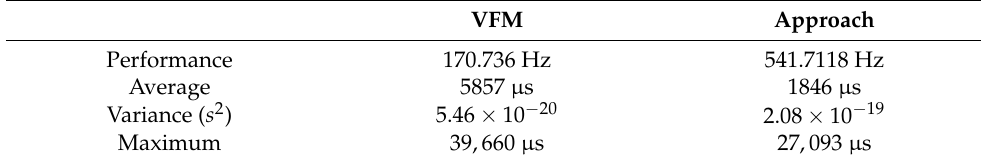
Table 8. Execution time comparison.